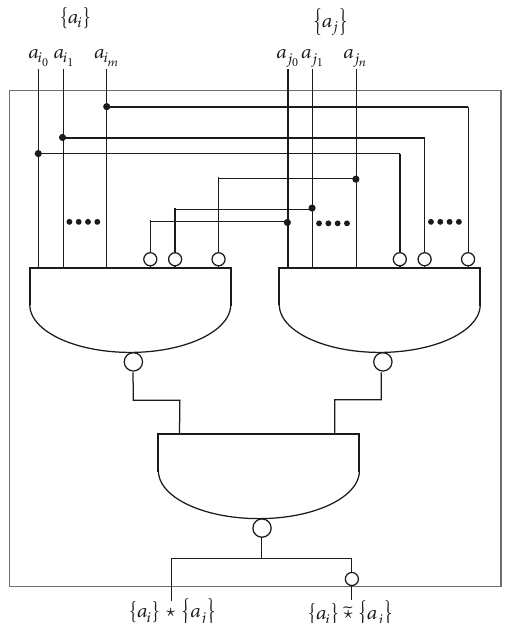
Figure 5: “NAND-only” implementation of the newly defined logical operations “ ⋆ and ̃⋆ ” that are essentially ⊕ (XOR) and ⊙ (XNOR) operations, respectively, for a two-input